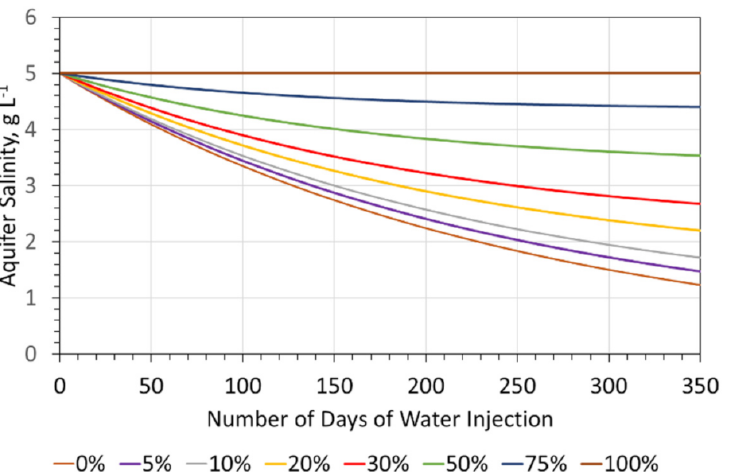
Figure 13. Change in aquifer salinity within the desalination zone, as a function of time, and the proportion of water within the desalination zone, which is fresh saline feed water, derived from the wider aquifer. The initial aquifer salinity = 5 g L − 1 . The volume of water processed each day is 1% of the water volume enclosed by the infiltration wells (Figure